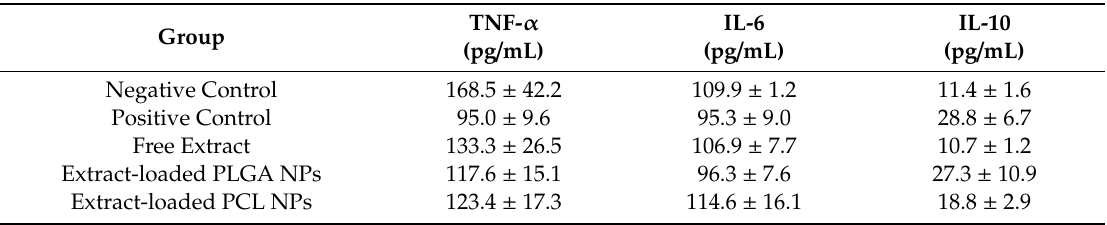
Table 4. Status of the di ff erent parameters evaluated in the plasma of the rats for each group (mean ±